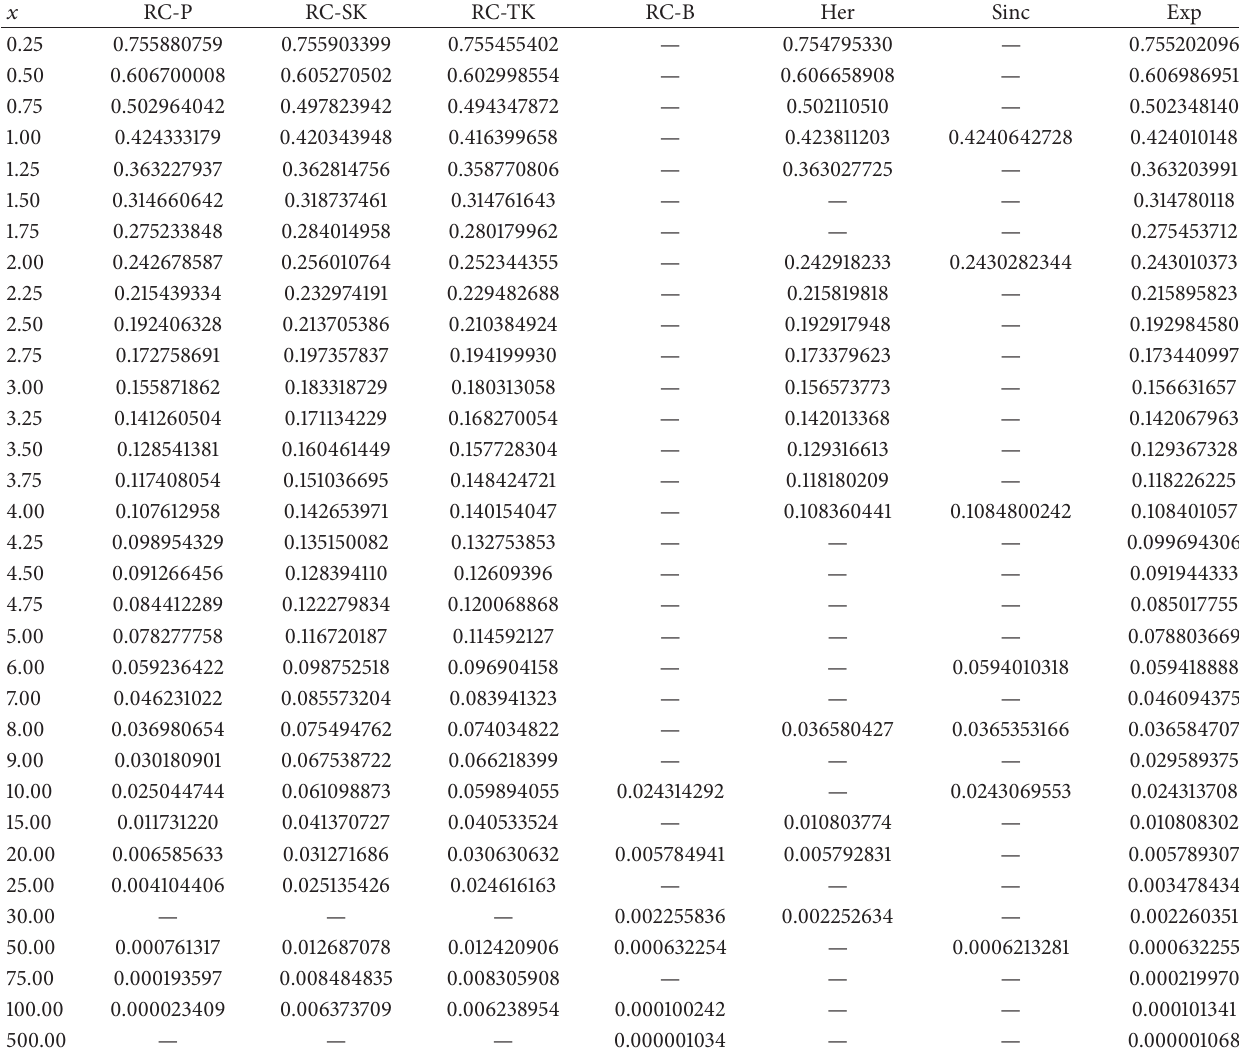
Table 2: Comparison of the approximate solutions 𝑦 of the TF equation acquired by spectral methods based on different basis